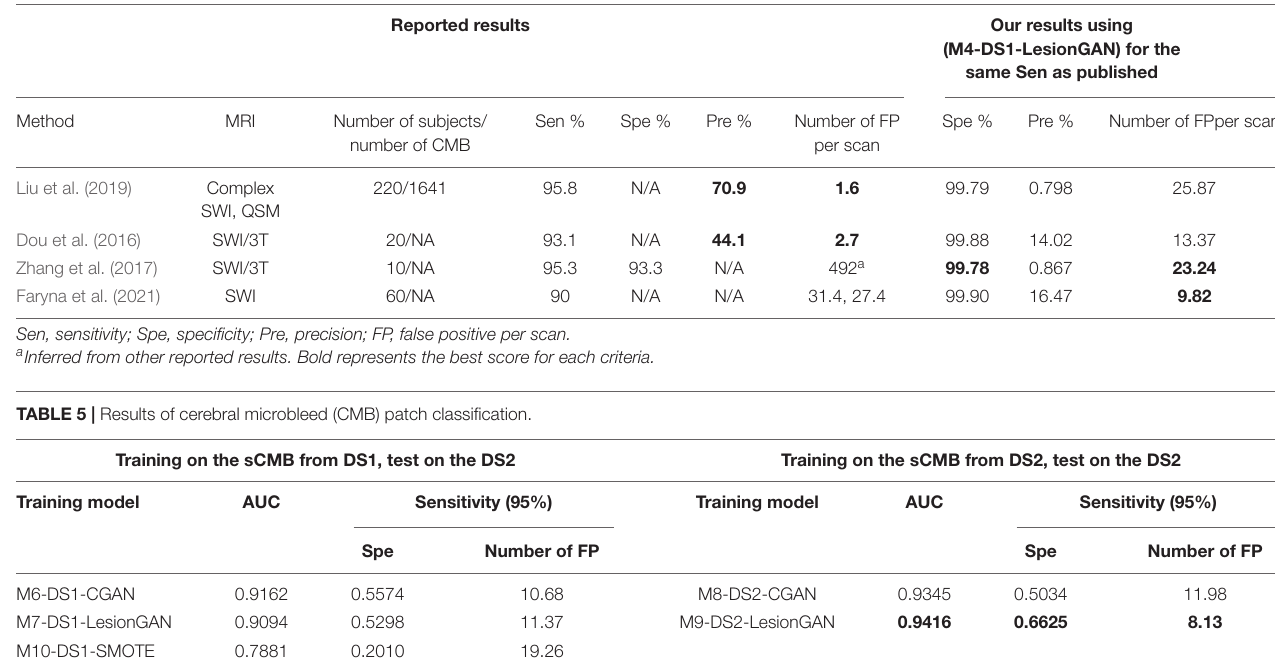
(M4-DS1-LesionGAN) for the same Sen as published